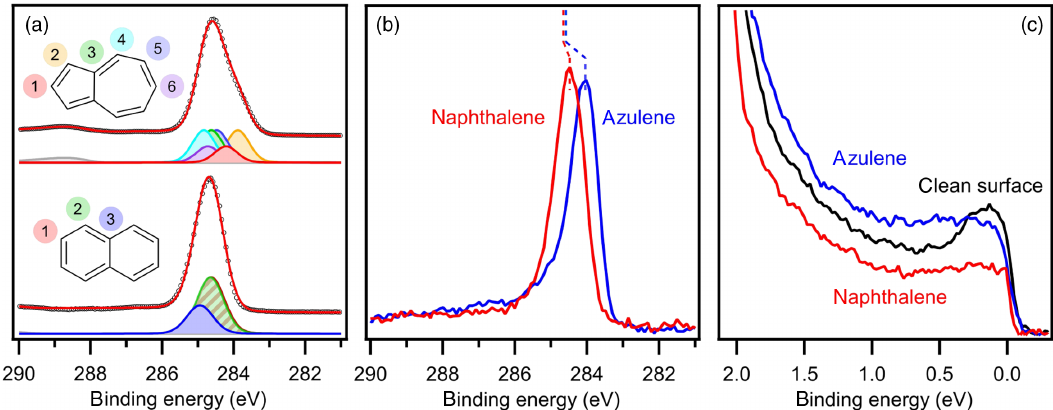
FIG. 4. Photoelectron spectra: (a) Multilayer C 1s XP spectra of azulene and naphthalene, compared with a theoretical model based on DFT calculations. Black circles are experimental data; red lines are fitted results from DFT-based model calculations. The colors of the component peaks correspond to the colors of the labels on the molecular formulas. The shake-up satellite of azulene is shown in grey. (b) C 1s XP spectra of monolayers of azulene and naphthalene on Cu(111). The dotted lines indicate the shifts relative to the multilayer peak positions. (c) UP spectra of azulene and naphthalene monolayers and of the clean Cu(111) surface, taken with a photon energy of 16.5